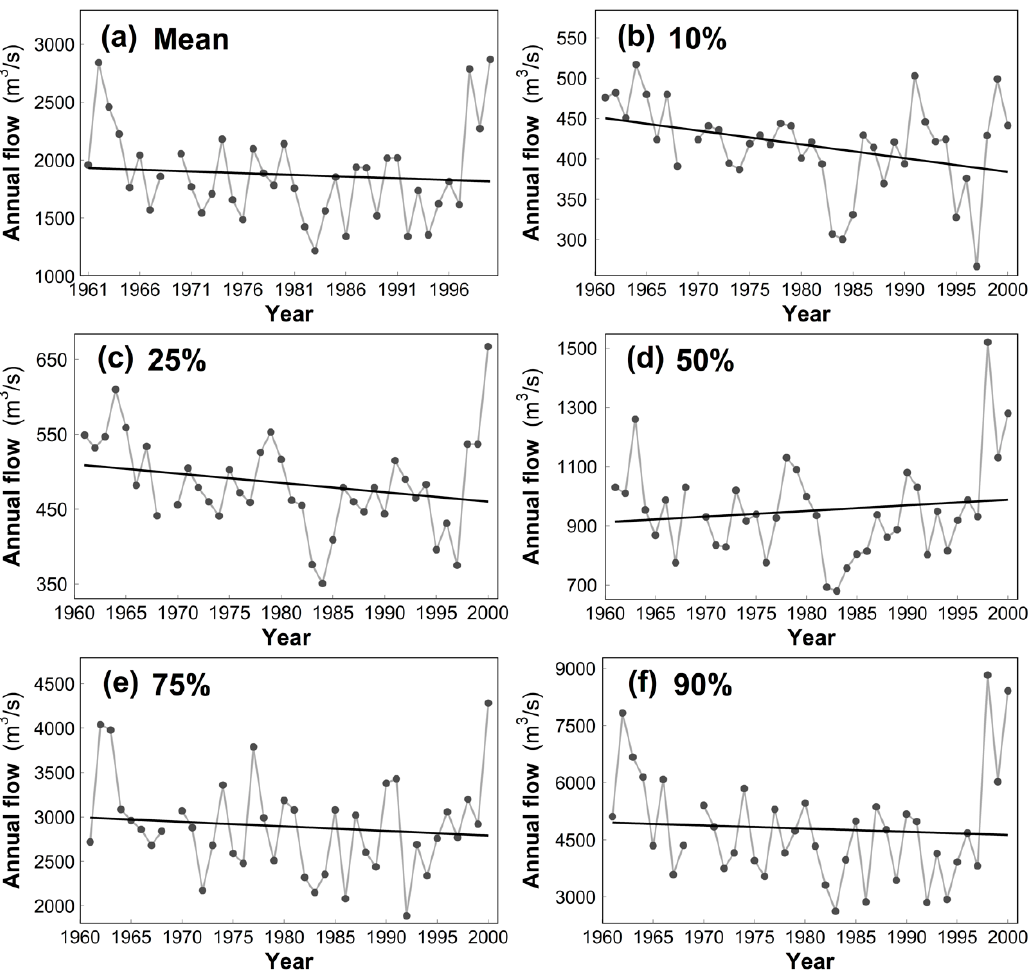
Figure 4. ( a ) Trend in mean and ( b – f ) different percentiles (10th, 25th, 50th, 75th and 90th) of annual daily flows of the Yarlung Zangbo River Basin.